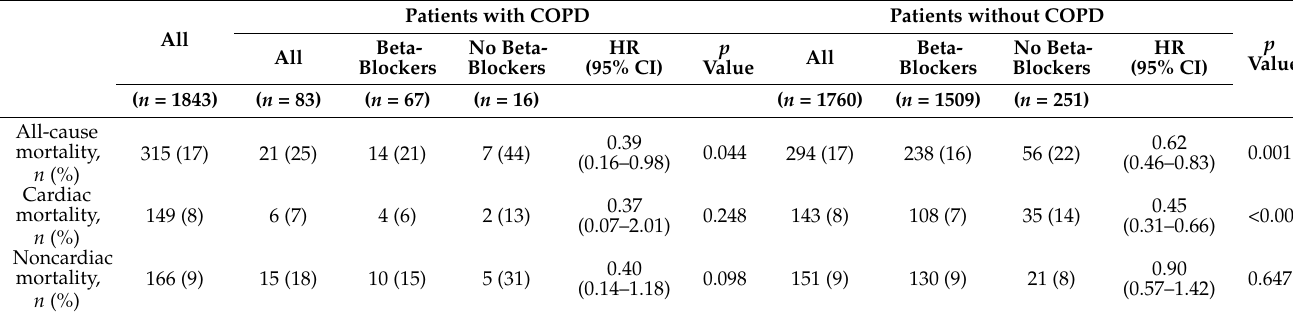
Table 3. An association of beta-blockers with 2-year prognosis in patients with and without COPD. Patients with COPD Patients without All